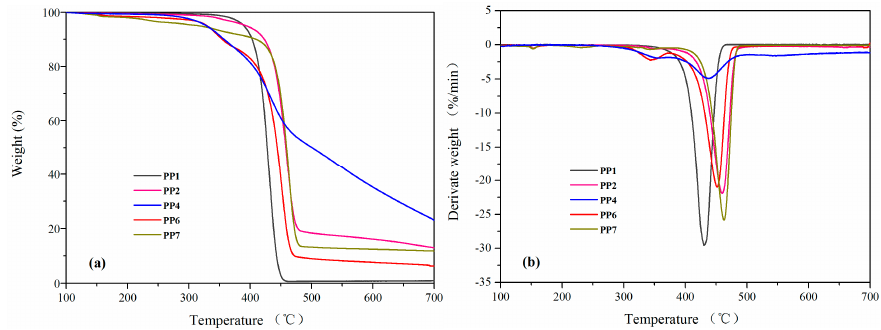
Table 3. TGA and DTG data of PP and PP composites under N 2 .